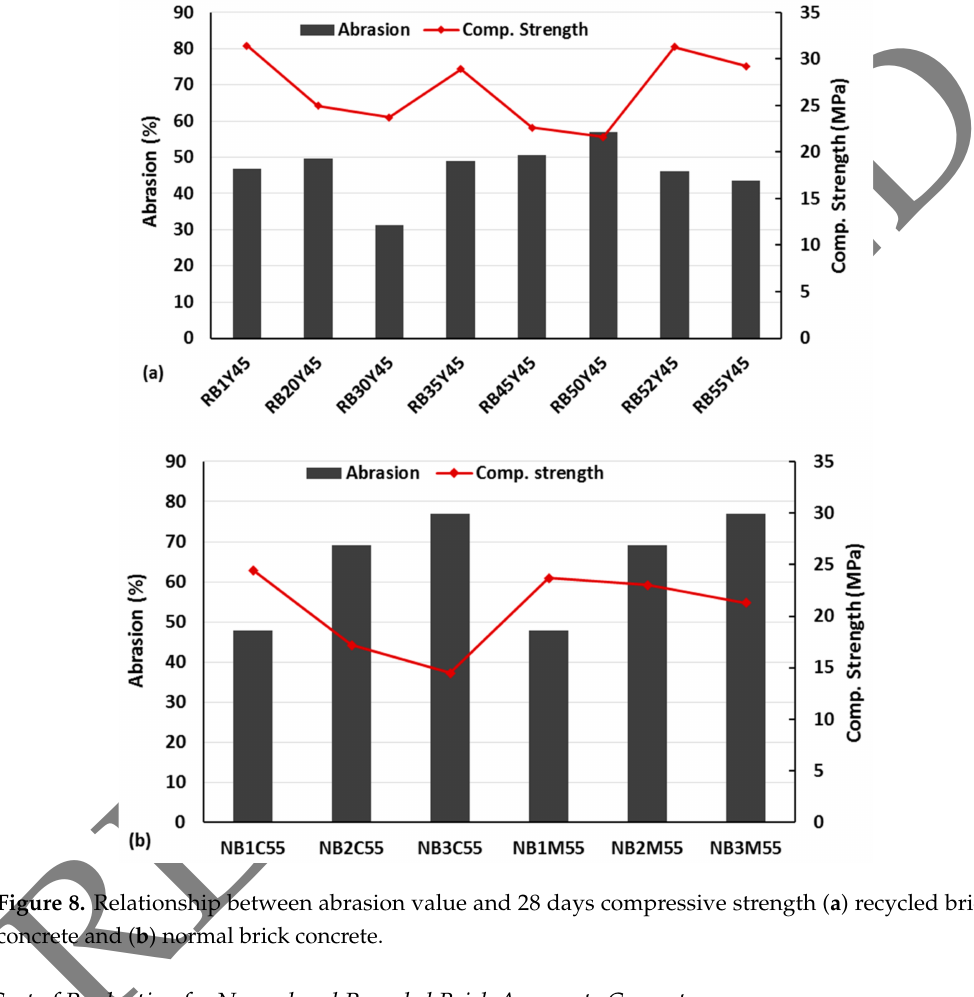
Figure 8. Relationship between abrasion value and 28 days compressive strength ( a ) recycled brick concrete and ( b ) normal brick